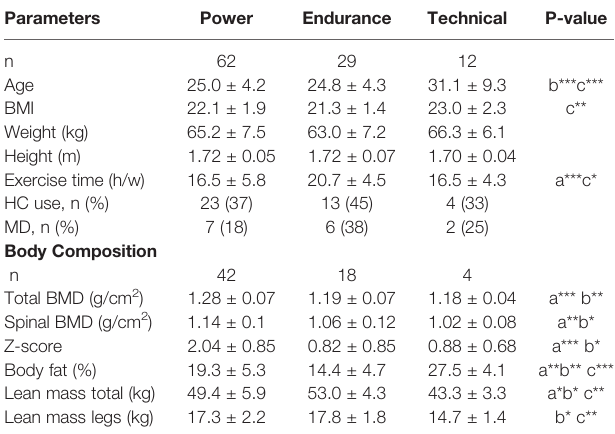
TABLE 3 | General parameters and body composition in female Olympic athletes of different sport categories power, endurance and technical. Parameters Power